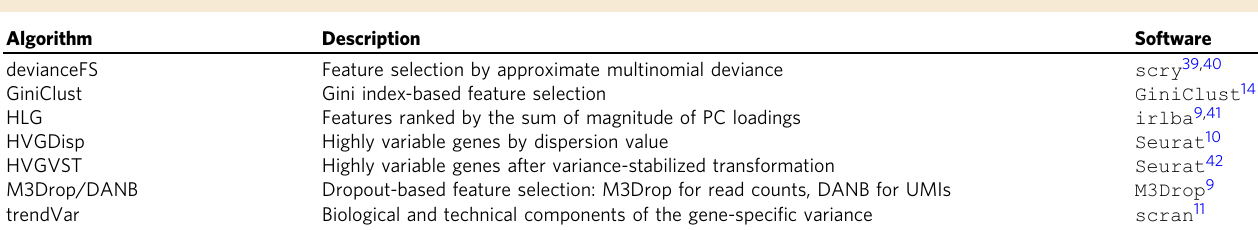
Table 1 Feature selection methods used for the benchmarking